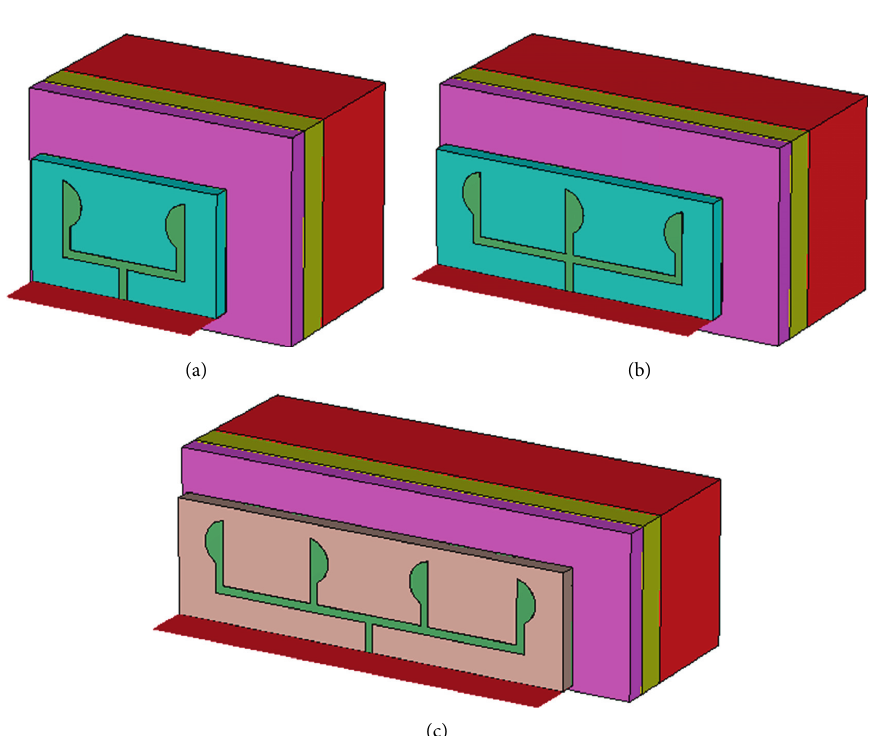
Figure 19: Array 2, 3, and 4 placed on top of the human phantom. (a) Array two. (b) Array three. (c) Array